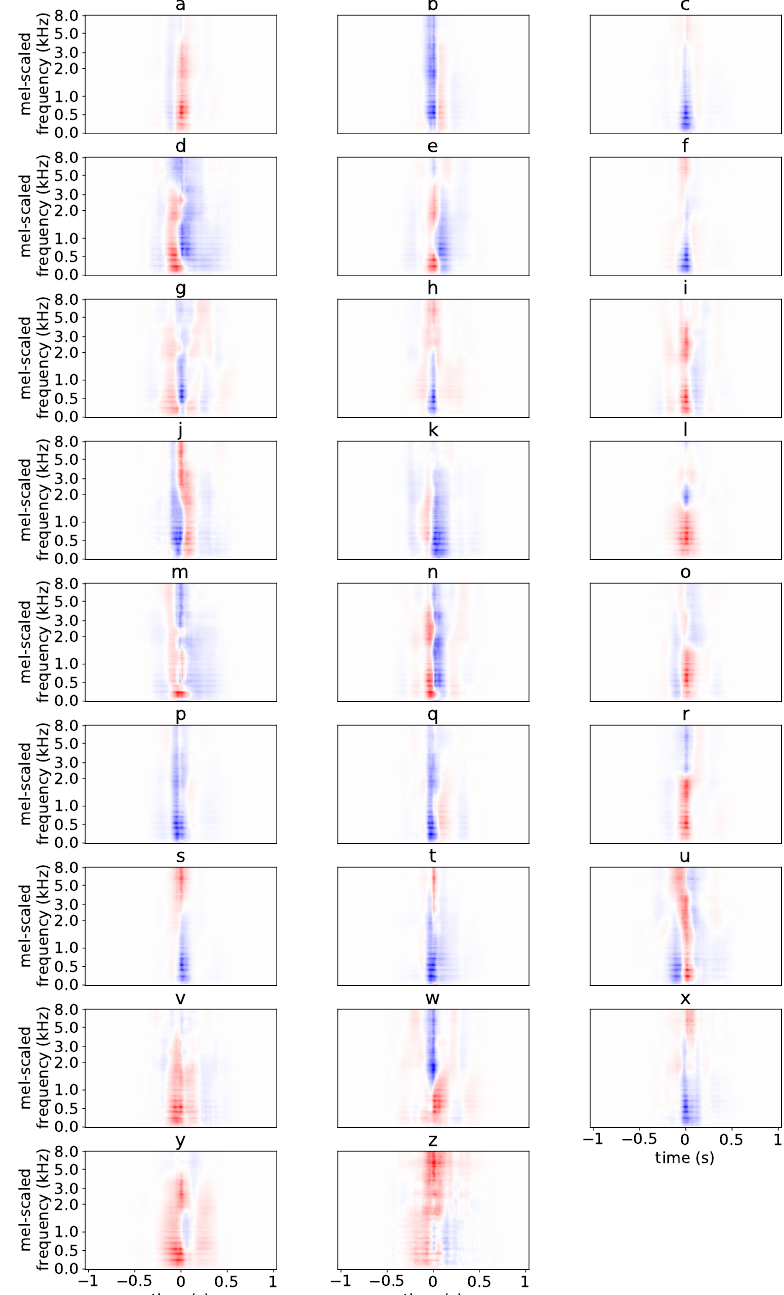
Figure A6. Input layer SNAPs in model W2L for all